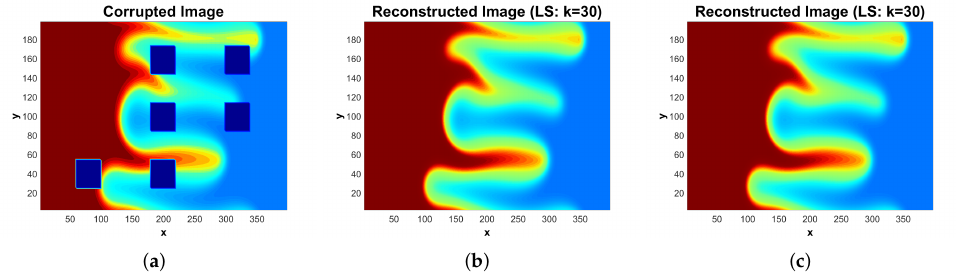
Figure 8. (Numerical Test 3) Example of an incomplete image ( a ), with the reconstructions from the standard least-squares with SVD ( b ) and the accelerated least-squares with rSVD ( c